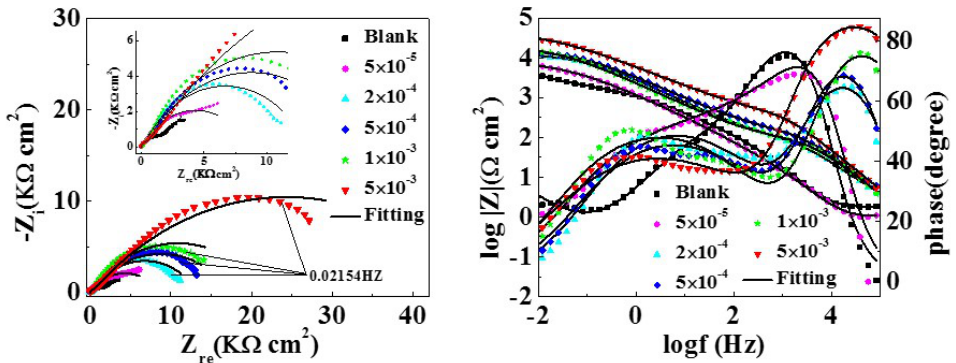
Figure 2. Nyquist and bode plots for the copper electrode with and without different concentrations of MTT in 3% NaCl at 298 K.